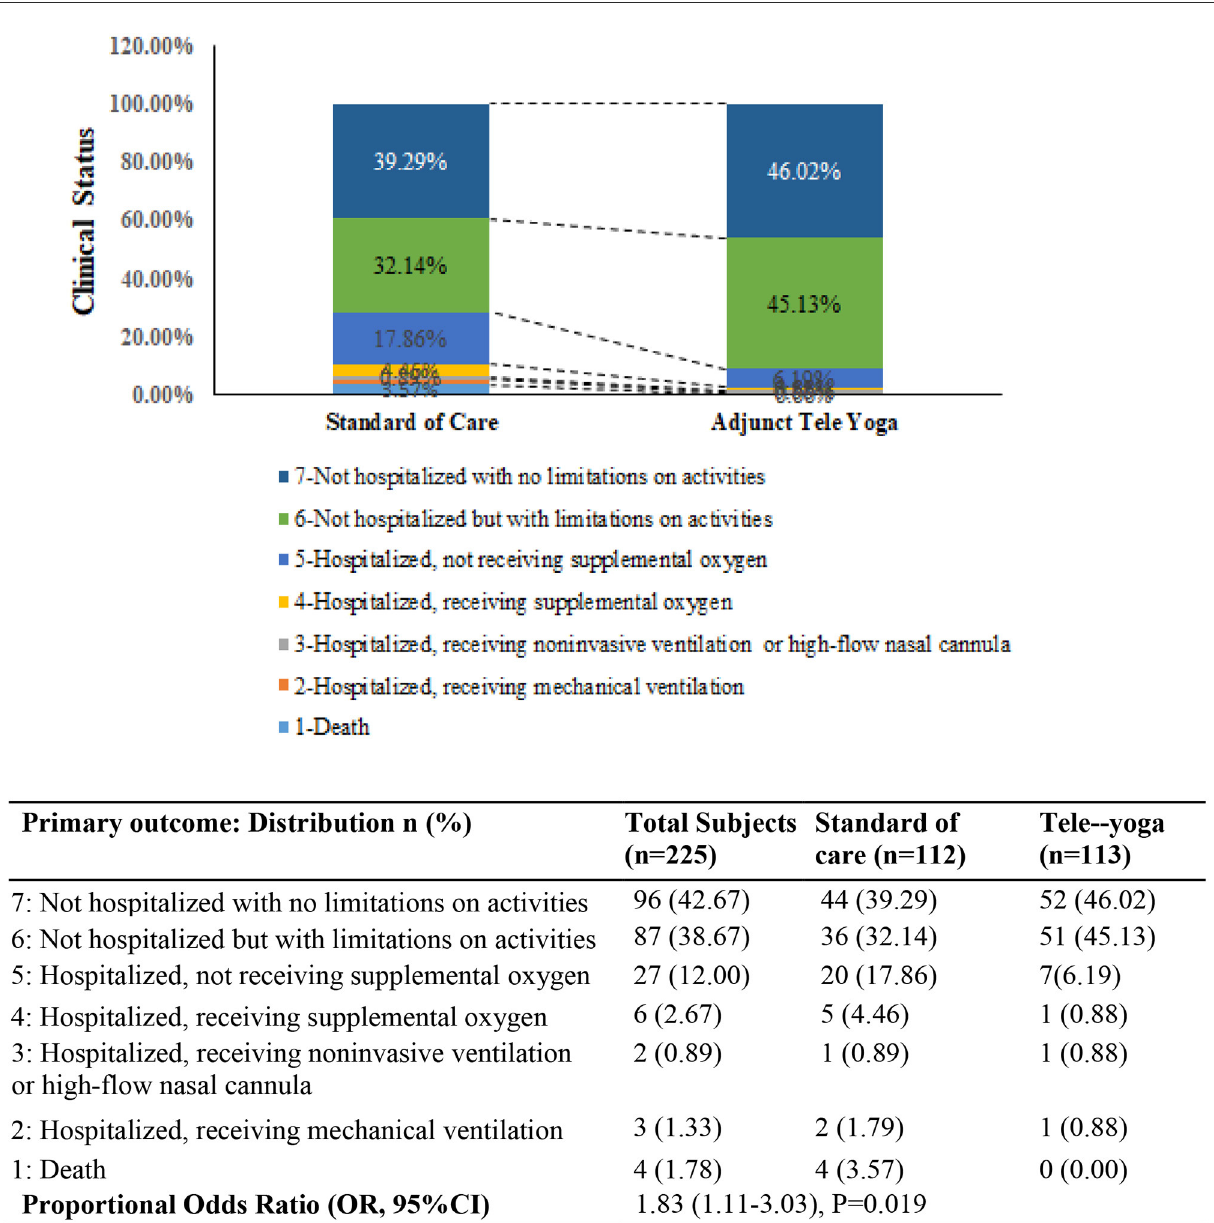
clinical status on the 7th day (partially adjusted for age odds ratio, 3.61; 95% CI, 2.11–6.05; P < 0.001), but the follow-up outcome on 28th day was not significant (adjusted odds ratio, 1.70% CI = 1.03–3.44) (Supplementary Table S5). On day 5,